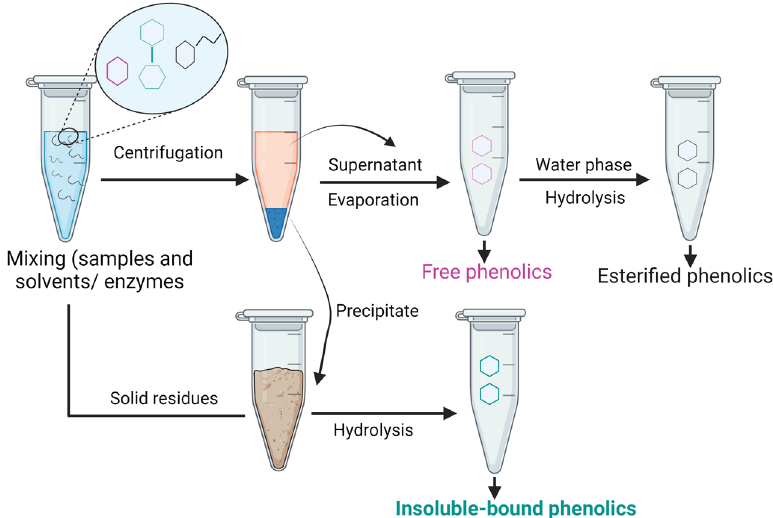
Figure 5. Schematic diagram of IBPs extraction .